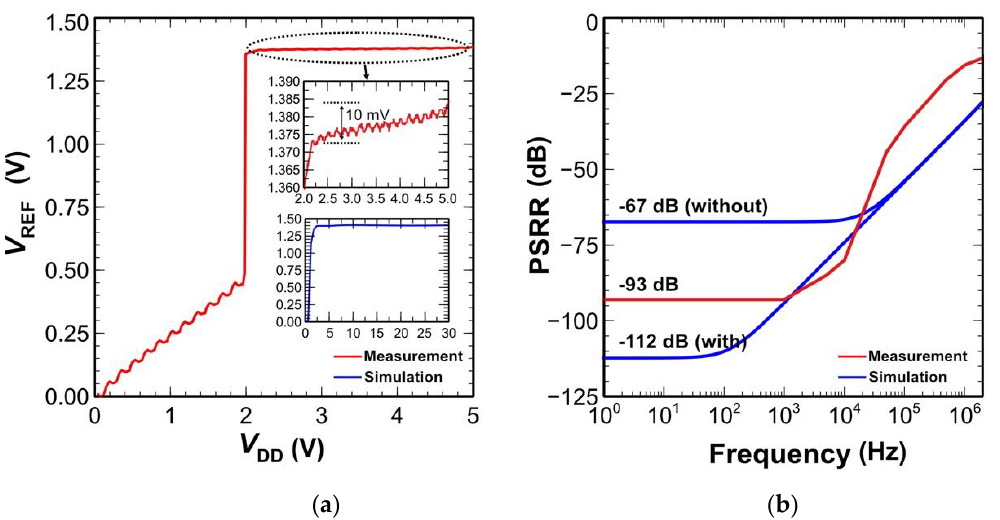
Figure 4. Measured results of ( a ) line regulation and ( b ) power supply rejection ratio (PSRR).